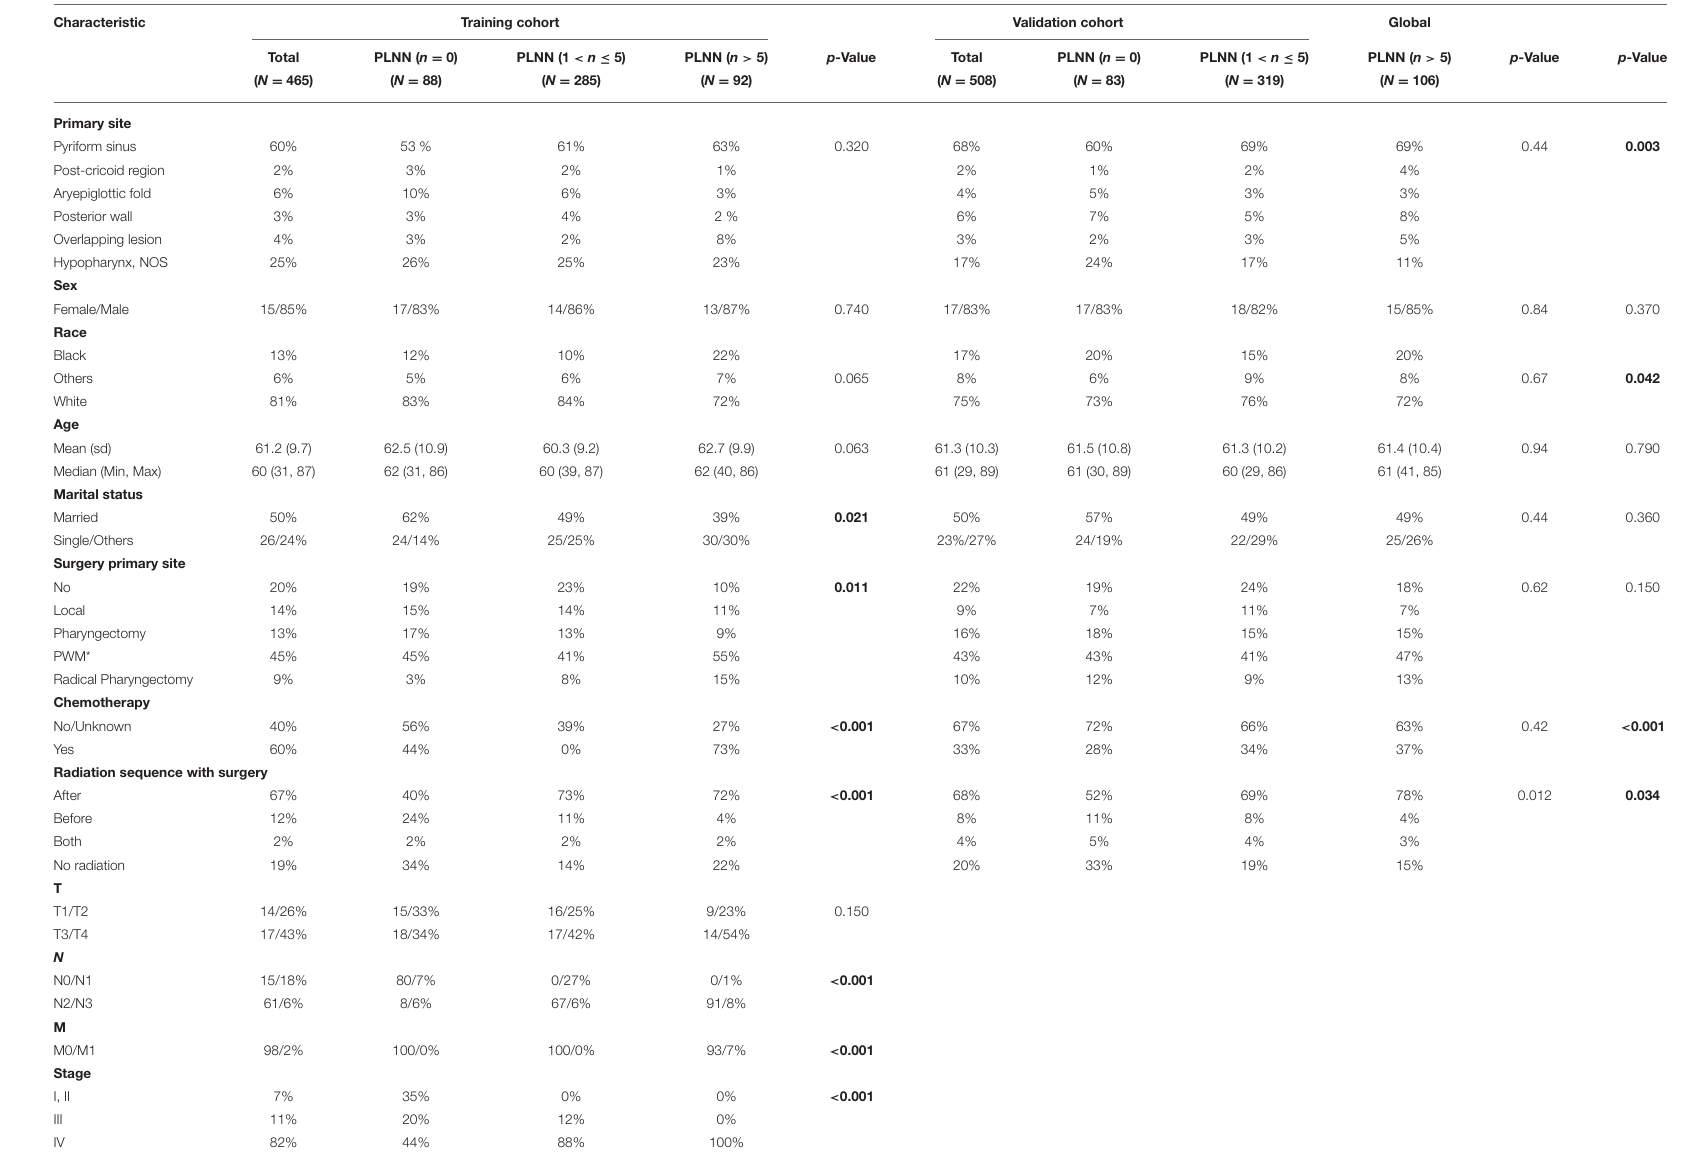
TABLE 1 | Clinical and demographic characteristics of total patients (full samples, N =